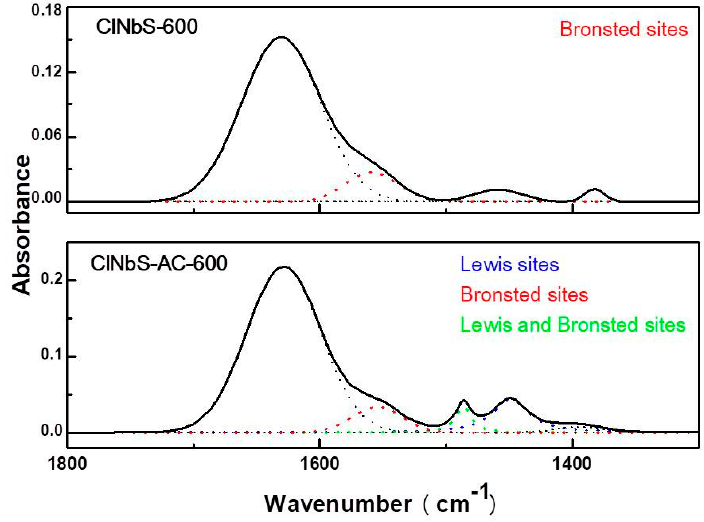
Figure 3. IR spectra for acidity analysis by pyridine adsorption on ClNbS-600 and ClNbS-AC-600